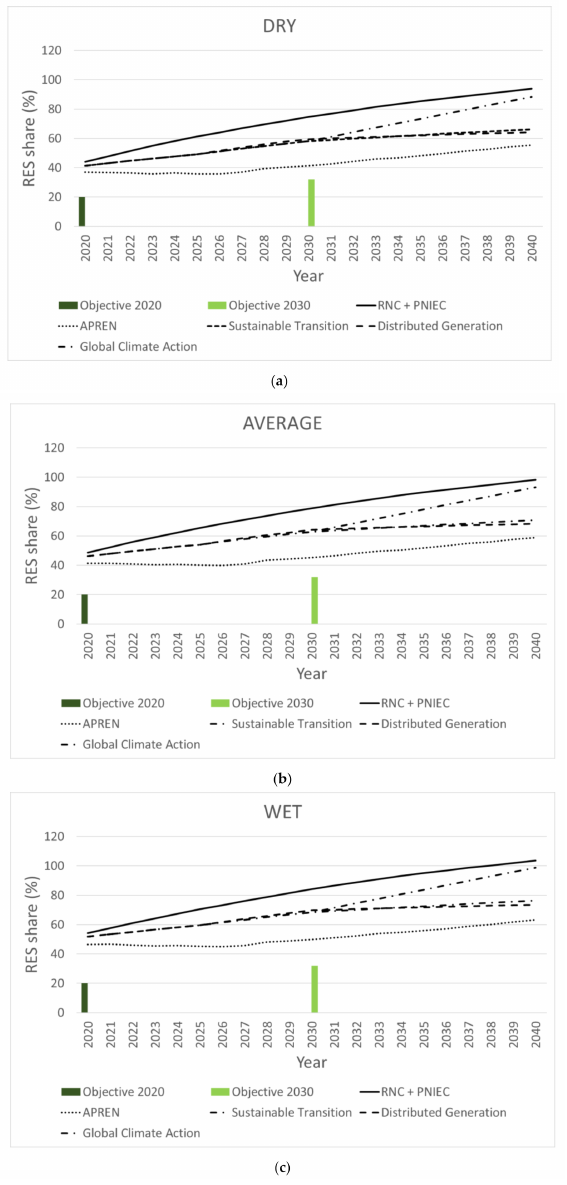
Figure 5. RES share in the electricity consumption and European objectives for different hydro profiles: ( a ) hydro dry profile; ( b ) hydro average profile; ( c ) hydro wet